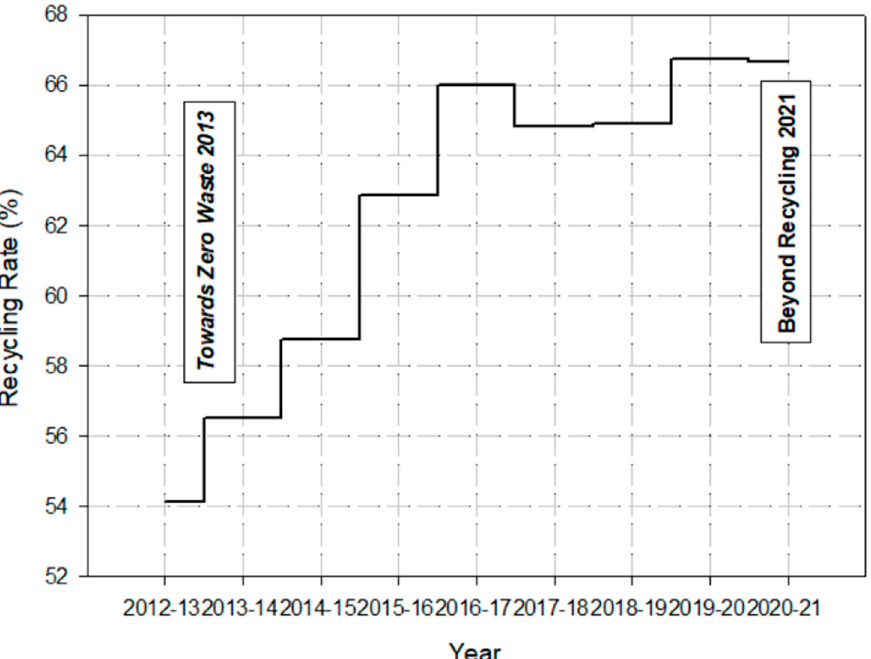
Figure 11. The impact of recent policy changes on recycling rate—Source: WasteDataFlow and Government Publications.